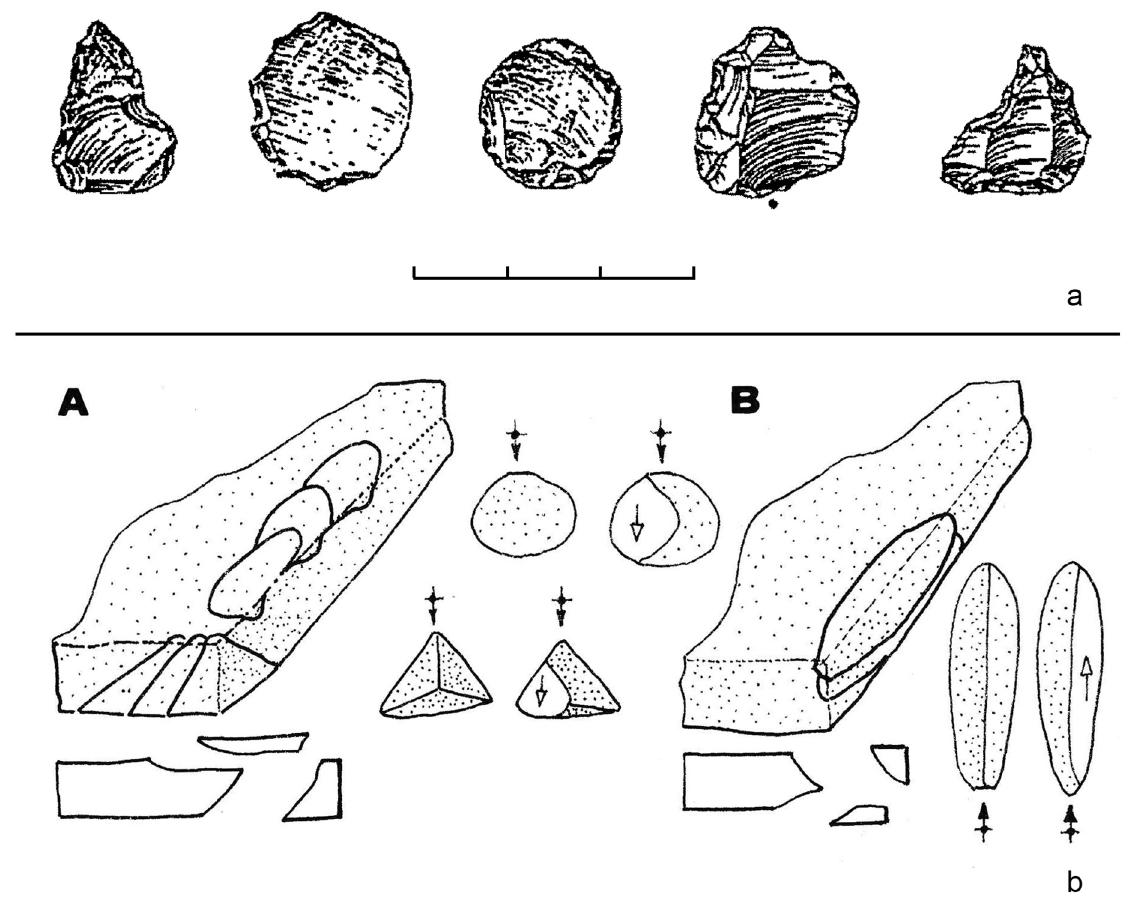
Fig 22. Microlithic tools component recognized in the G-Complexes (a); flakes produced from the initialization and shaping of Keilmesser (b). Modified from Richter